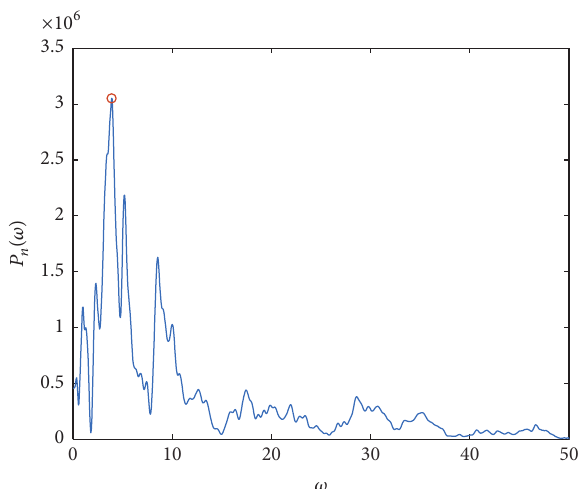
Figure 2: The Lomb periodogram analysis of 𝑠(𝑡) , where 𝑃 𝑛 (𝜔) is a normalized Lomb power (since 𝑃 𝑛 (𝜔) is a normalized Lomb power, ]/𝜎 𝑠(𝑡) and [𝑠(𝑡) − 𝜇 𝑠 𝑠 have identical Lomb periodogram, where and 𝜎 2 s , resp., denote the mean and variance of this residuals 𝑠(𝑡) ) and 𝜔 is the log-angular